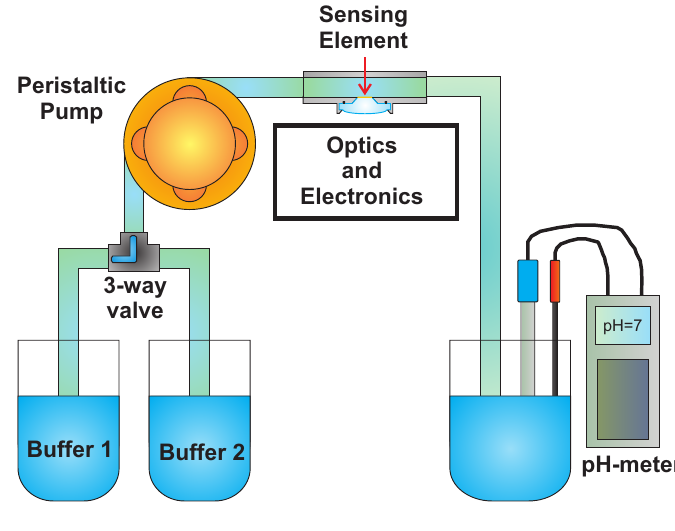
Figure 12. Schematic representation of the fluidic system used to measure the pH sensor response time. It consists of (i) a closed loop circulator, (ii) the optical head with the sensing element inside, (iii) a beaker with a glass electrode pH-meter to measure the pH of the solution and a thermocouple to measure the temperature of the solution and correct the pH value. A 3-way valve has been added to switch between two different buffer solutions.